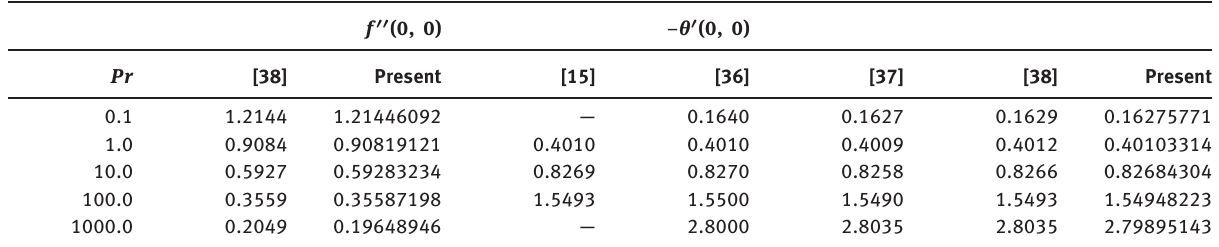
Table 1: Comparison values of f (cid:3)(cid:3) (0, 0) and − θ (cid:3) (0, 0) when Nt = 0.0, Nc = 0.0, Nr = 0.0, Sc = 1.0, Le = 1.0, 0.0 < Nb (cid:2) 1.0, Gr = 1.0, ε